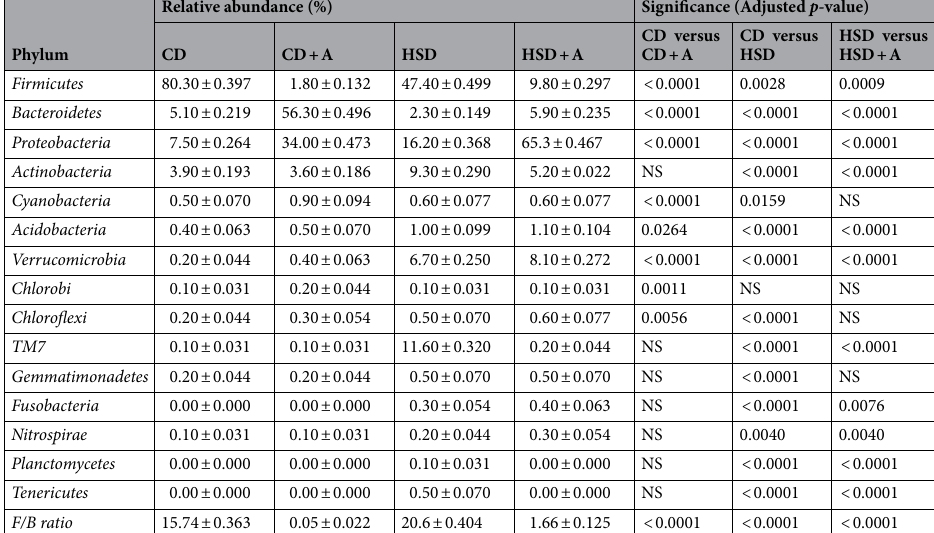
Table 5. Short term effect of high salt (4% in chow) diet followed by Amoxicillin treatment on the mean relative abundance of major bacterial groups at phylum level in mice. Values are expressed as the means ± SD. Data were analyzed by one-way ANOVA, followed by Bonferroni test, n = 6, p ≤ 0.05, NS = Not significant, CD: Standard—chow diet for 3 weeks; CD + A: Standard—chow diet for 3 weeks and subjected to Amoxicillin treatment in 3rd week; HSD: High-salt diet for 3 weeks; HSD + A: High-salt diet for 3 weeks and subjected to Amoxicillin treatment in 3rd week.